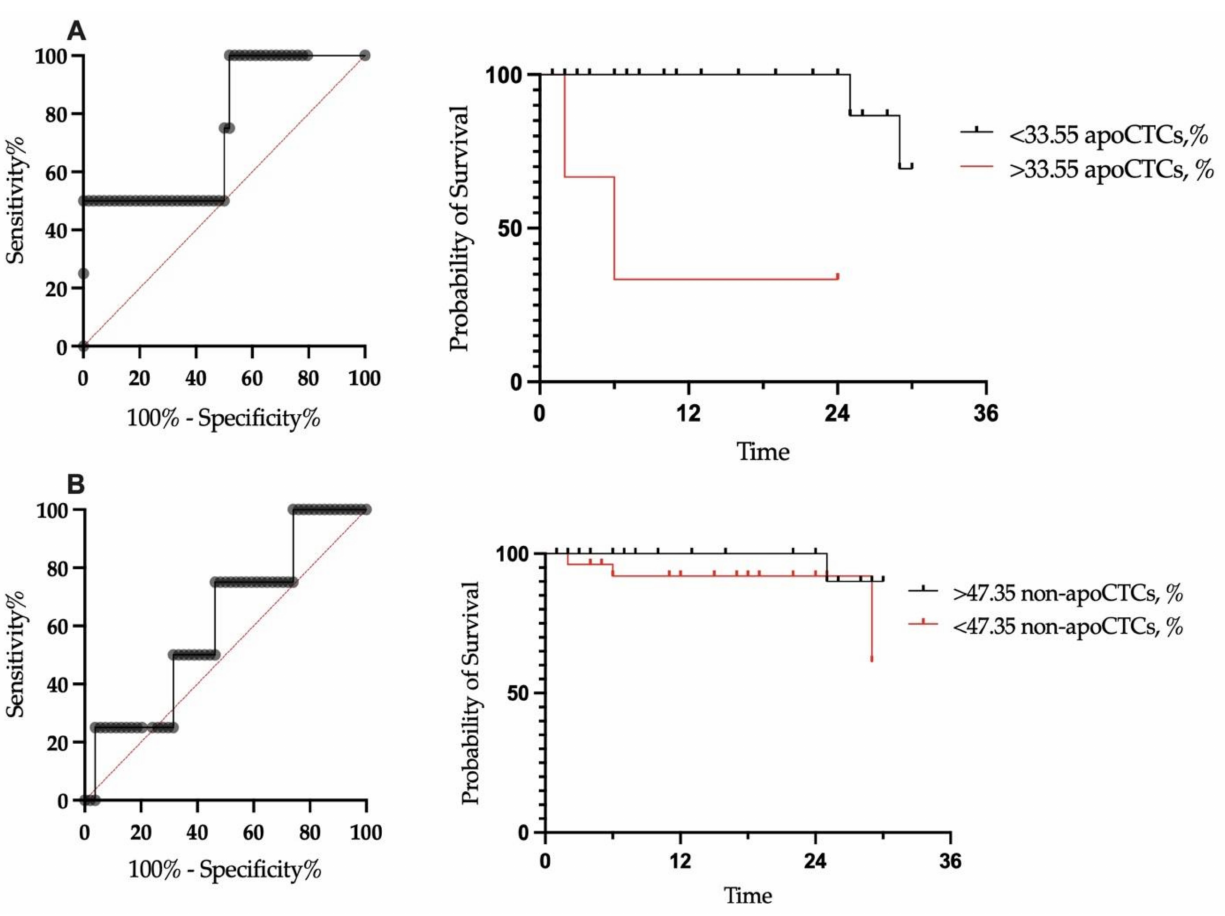
Figure 4. Metastatic-free survival of breast cancer patients in relation to proportion of apoCTCs ( A ) and non-apoCTCs ( B